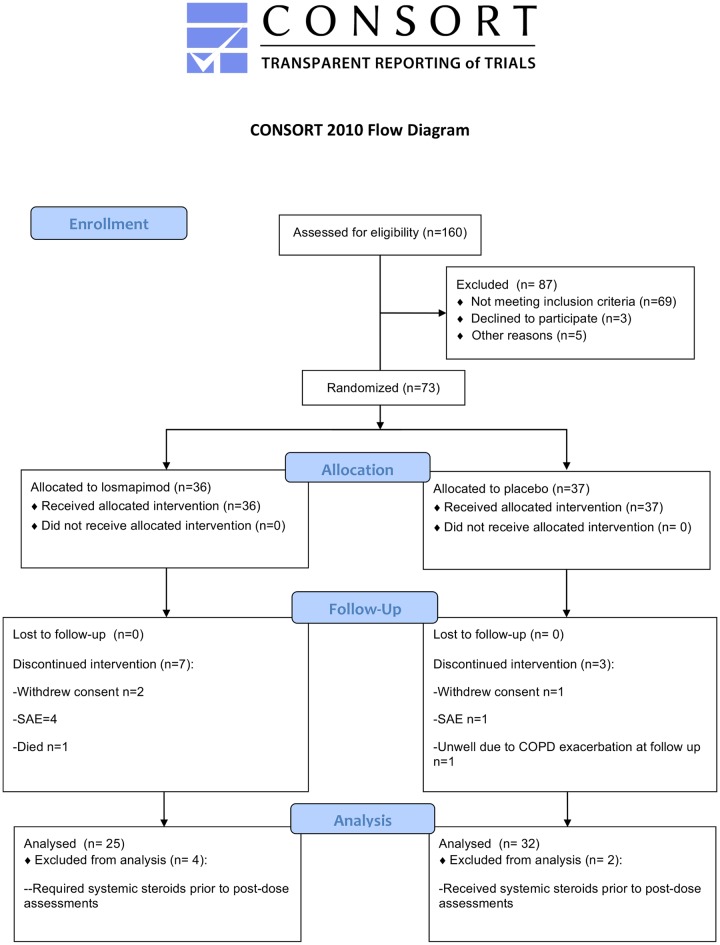
Consort diagram of EVOLUTION trial.(*expanded in S3 Table).